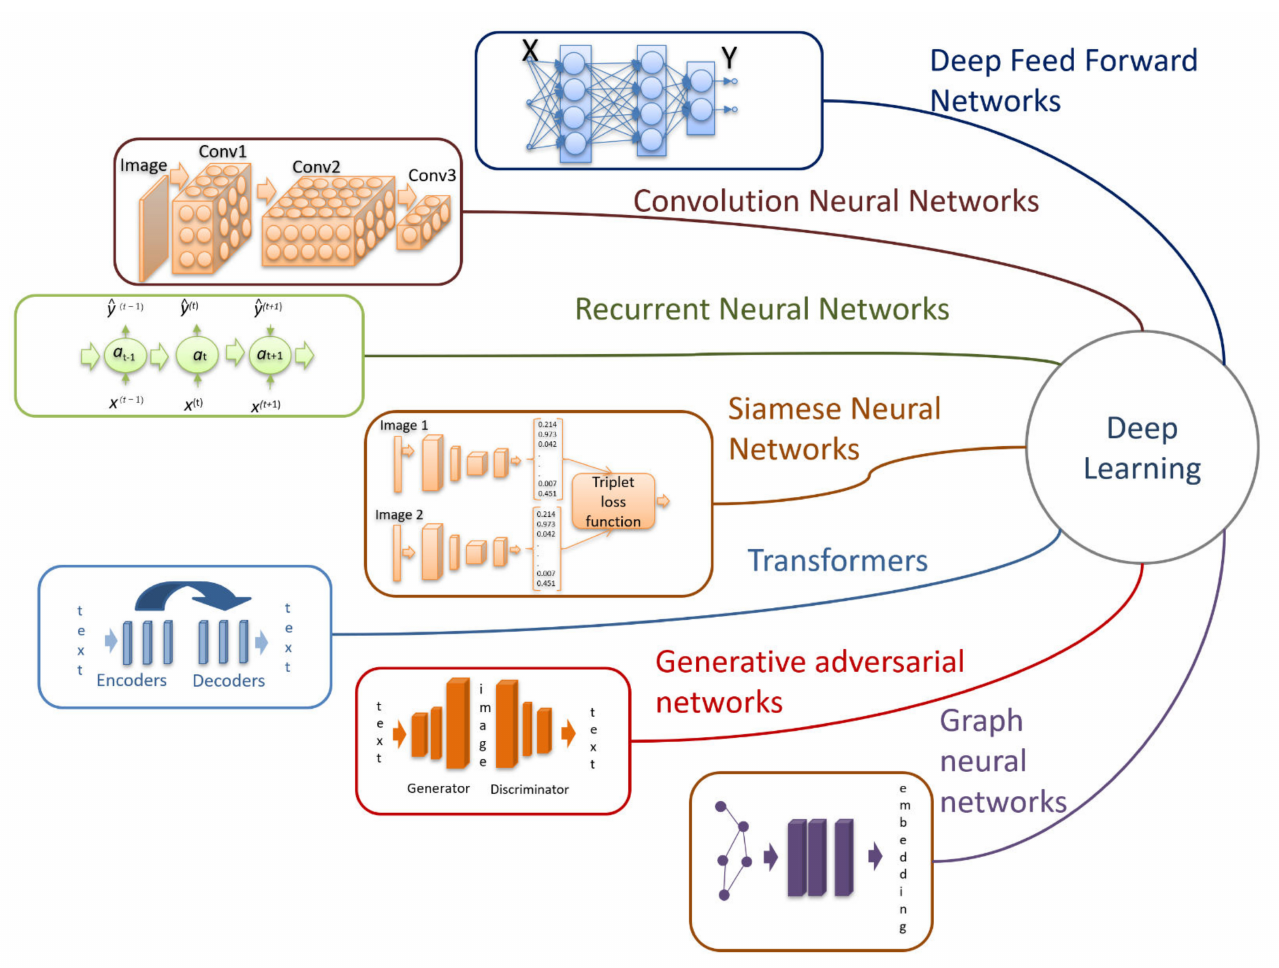
Figure 5. Deep networks. Source: generated by the